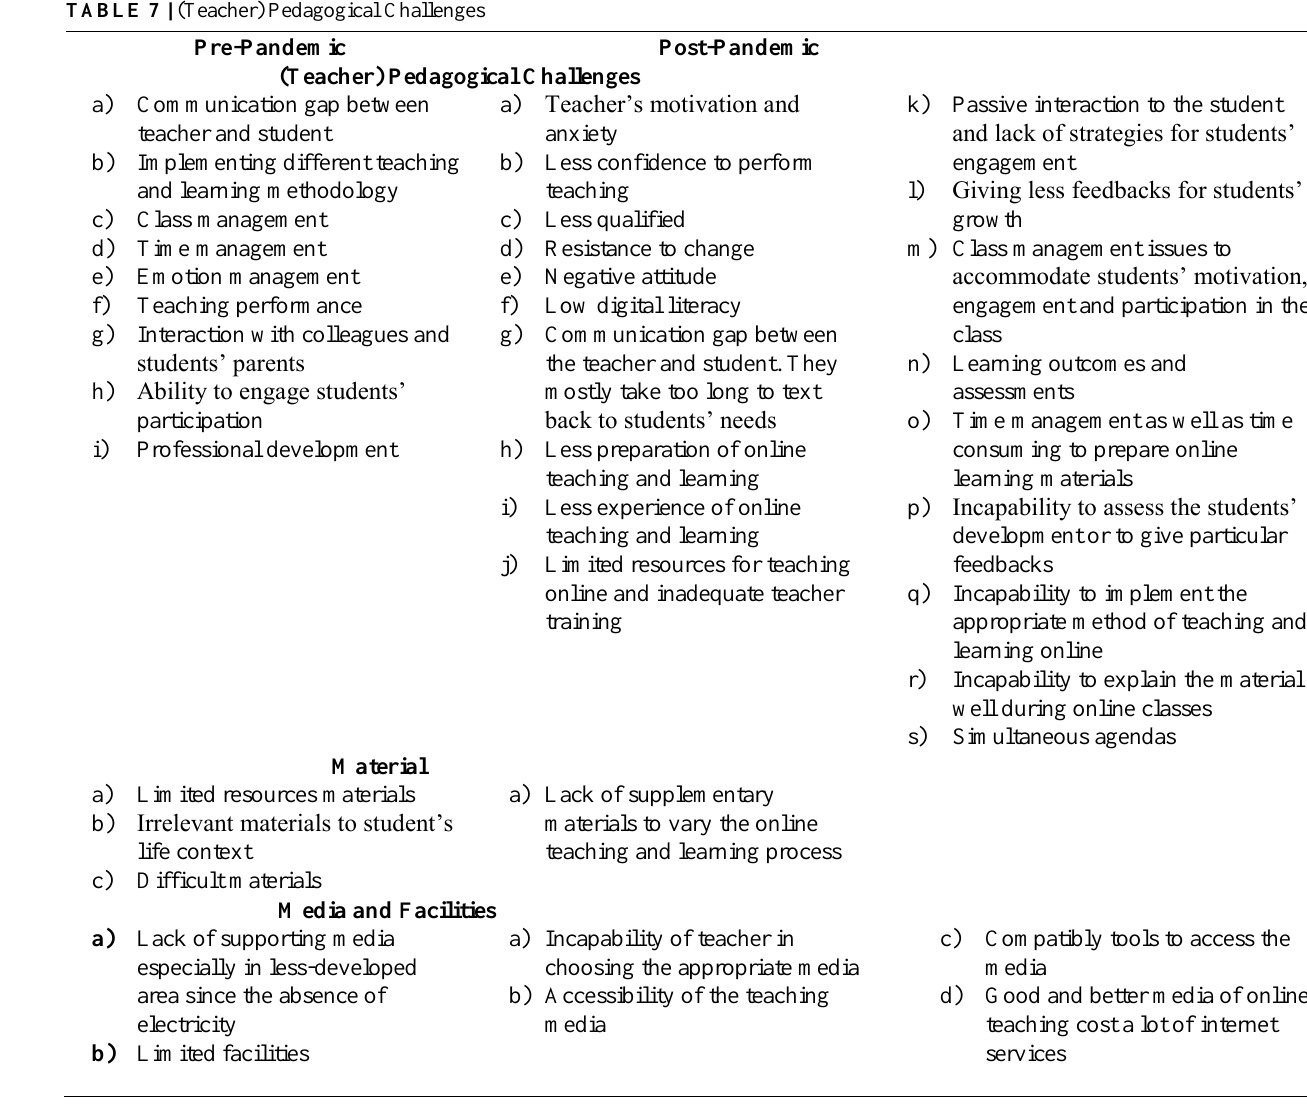
TABLE 7 | (Teacher) Pedagogical